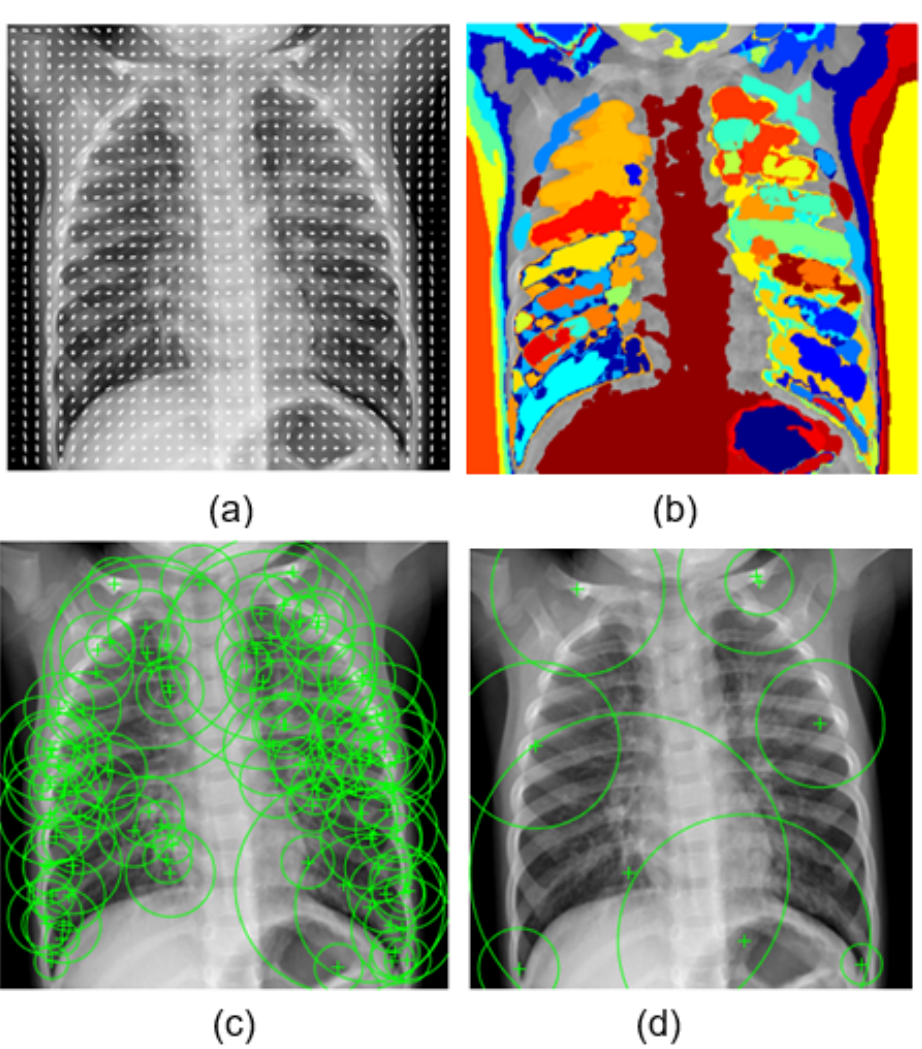
Figure 8. Sampling of ( a ) HOG, ( b ) MSER, ( c ) SURF, and ( d ) BRISK features on a lung opacity X-ray